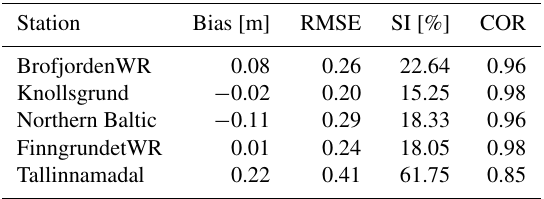
Table 1. Verification scores – root mean square error (RMSE), scat- ter index (SI, Zambresky, 1989), and correlation (COR) – for sig- nificant wave height simulated by WAVEWATCH III ® driven by UERRA/HARMONIE-v1 for January